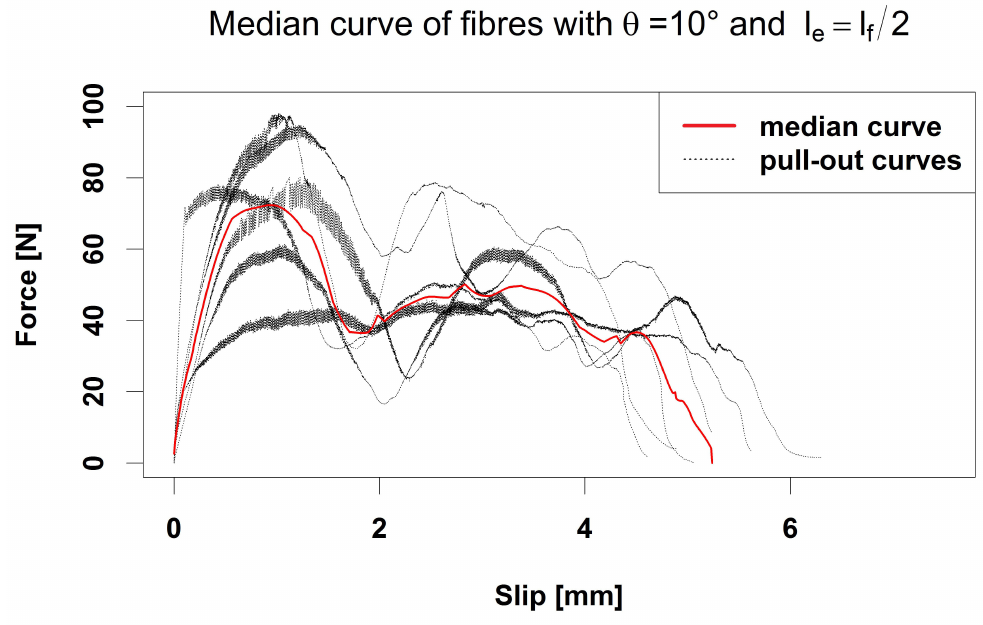
Figure 1. Median curve (red solid) of the single-fibre pull-out curves (black dotted) with angle θ = 10 ◦ and l e = l f /2.